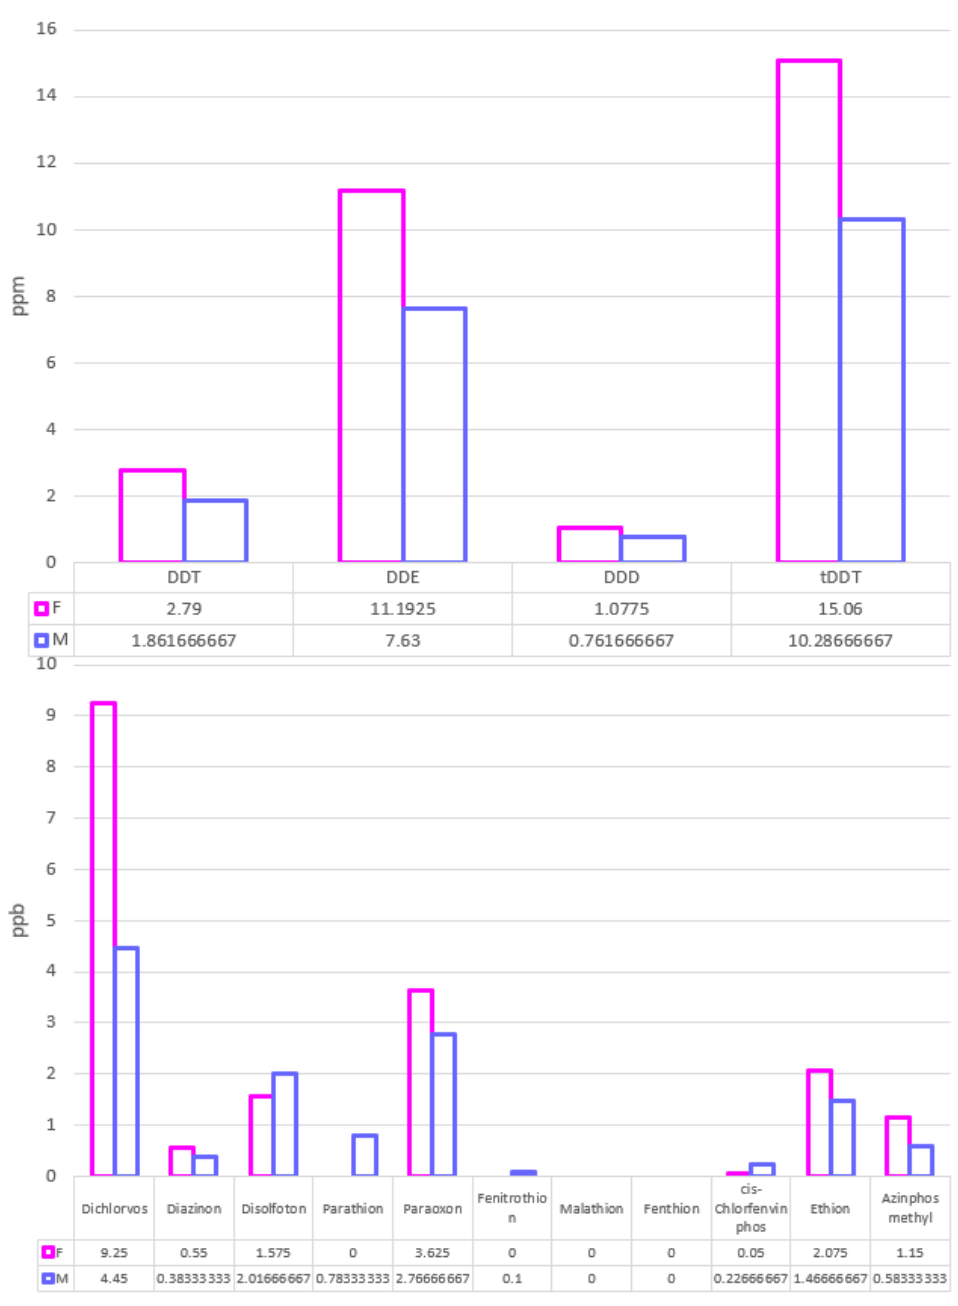
Figure 4. Sex-dependent and average concentration on a lipid weight base of DDTs (ppm) and OPs (ppb) in the blubber of south-eastern Caspian seals.